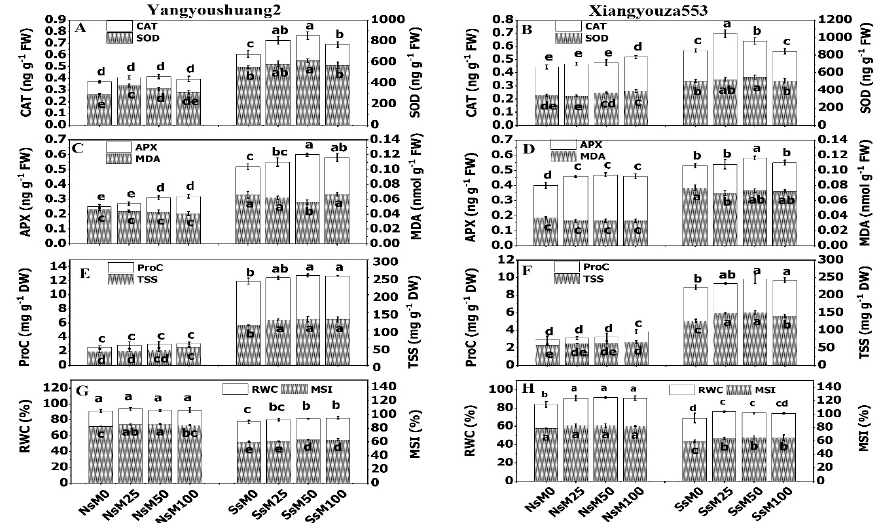
Figure 2. Response of catalase (CAT), superoxide dismutase (SOD), ascorbate peroxidase (APX), malondialdehyde level (MDA), relative water content (RWC), membrane stability index (MSI), proline content (ProC), and total soluble sugars (TSS) of B. napus L. cultivars to seed priming with 0 µM (M0), 25 µM (M25), 50 µM (M50), and 100 µM melatonin (M100) under non-NaCl salt stress (Ns) and NaCl salt stress (Ss). ( A ) CAT and SOD of Yangyoushuang2; ( B ) CAT and SOD of Xiangyouza553; (C) APX and MDA of Yangyoushuang2; ( D ) APX and MDA of Xiangyouza553; ( E ) ProC and TSS of Yangyoushuang2; ( F ) ProC and TSS of Xiangyouza553; ( G ) RWC and MSI of Yangyoushuang2; ( H ) RWC and MSI of Xiangyouza553. Bars represent SD of three replicates. Different letters indicate significant differences among the treatments ( p < 0.05).